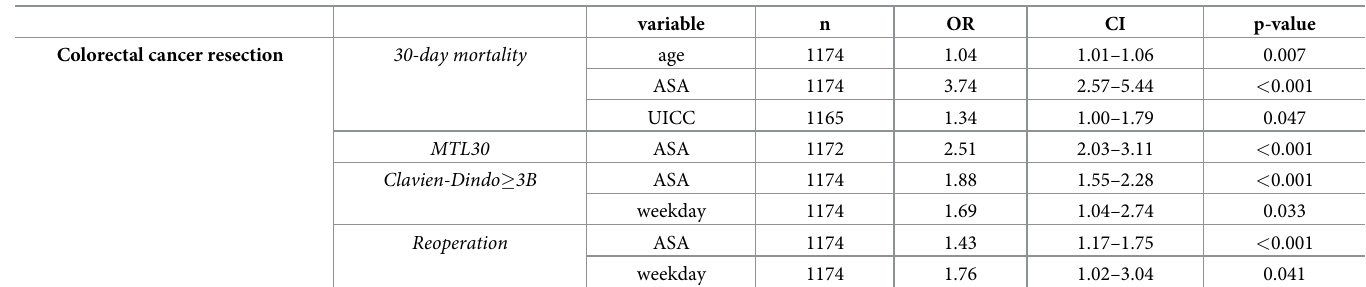
Table 4. Multivariable